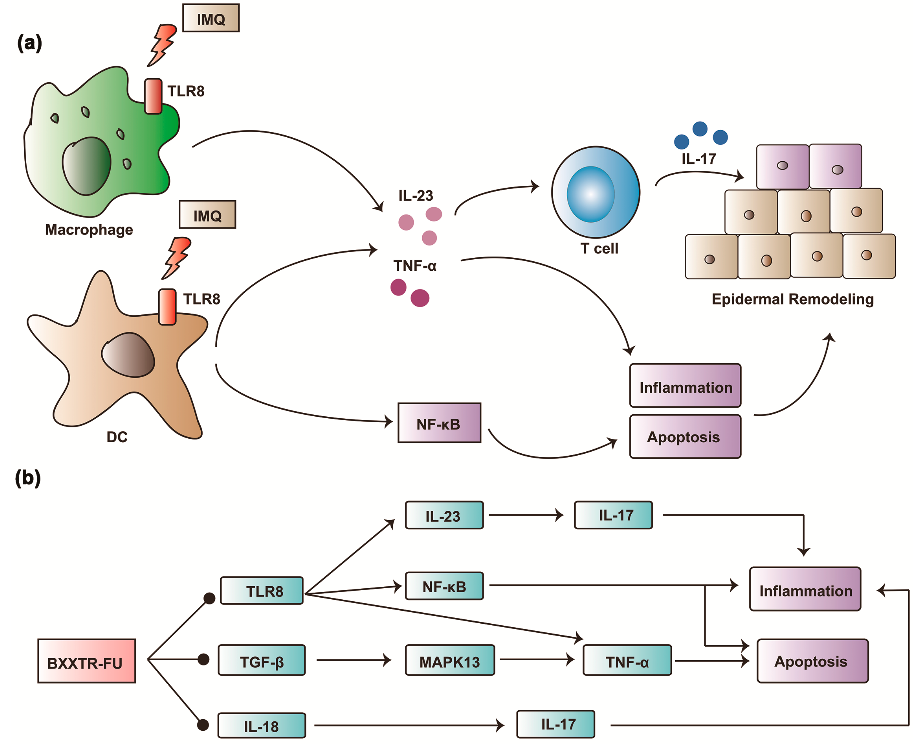
Figure 7. Schematic diagram of the anti-inflammation mechanism of BXXTR in IMQ-induced psoriasis-like skin inflammation. ( a ) IMQ stimulate TLR8 in macrophage and DCs thus to release IL23, TNF- α and NF- κ B to induce IL-17 dependent inflammation; ( b ) BXXTR could inhibit the expression of TLR8, TGF- β and IL-18 thus to inhibit the activation of TLR8-IL-23-IL-17, TLR8-NF- κ B, TGF- β -MAPK13-TNF- α and IL-18-IL-17 signaling pathways to inhibit apoptosis and inflammation.